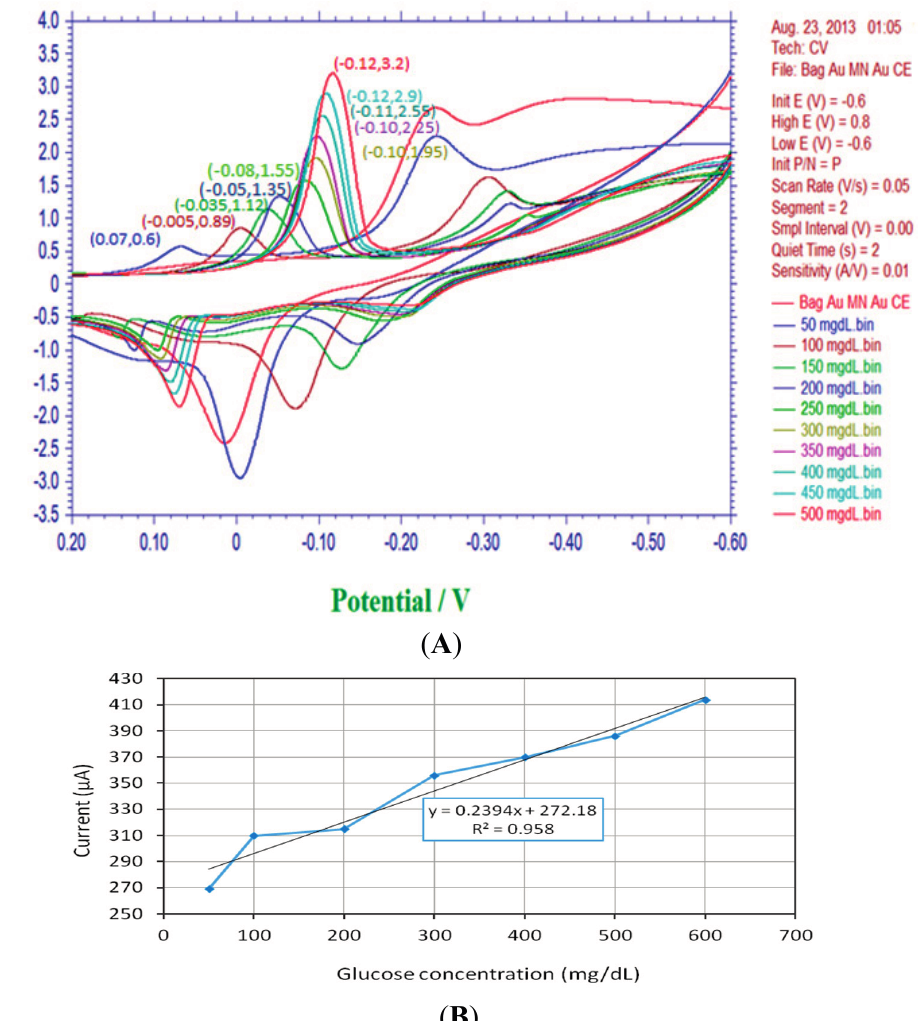
Figure 8. Cyclic voltammograms and calibration plot of the intra-oral biosensor module. ( A ) The cyclic voltammetric sweep shows the electrochemical relationships among current and applied potential with respect to different glucose concentrations (0~500 mg/dL); ( B ) The sensitivity expression and calibration plot of the amperometric